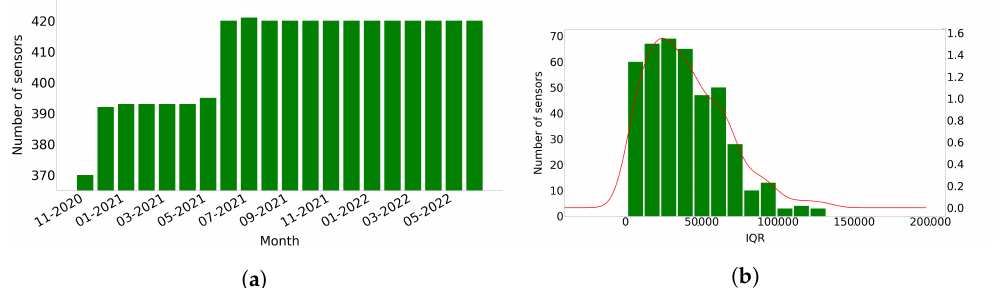
Figure 1. Number of sensors that produce traffic data per day and distribution of the IQR of the number of vehicles measured by each sensor. ( a ) Number of sensors that produce traffic data each month. ( b ) Distribution of the IQR of the vehicles measured by each